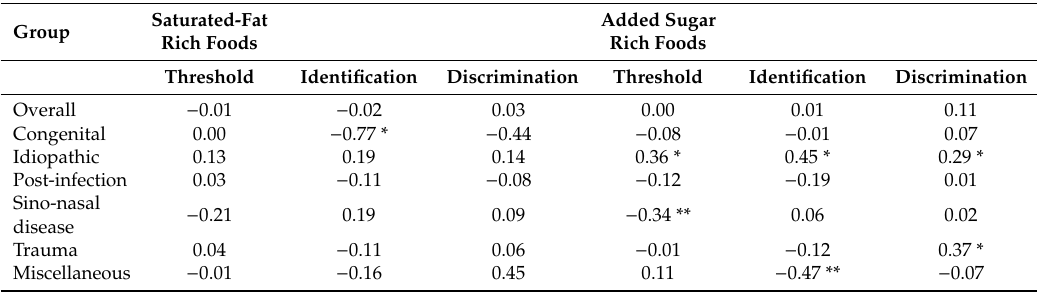
Table 5. Exploratory zero-order correlations between two key components of a Western-style diet (Dietary fat and sugar scale: DFS), and measures of olfactory impairment overall, and across the di ff erent